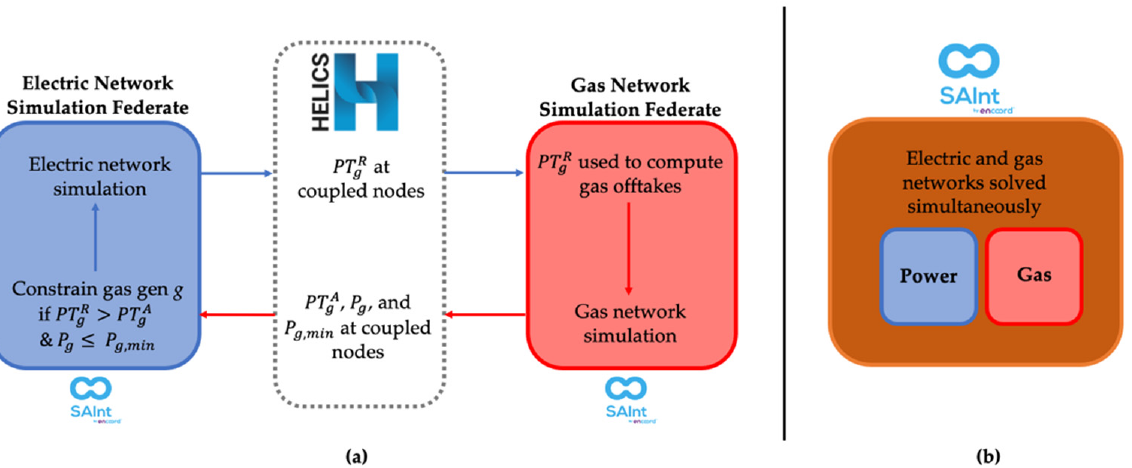
Figure 1. Conceptual depiction of the ( a ) co-simulation framework developed in this study, with a comparison to ( b ) the integrated simulation approach used for benchmarking.